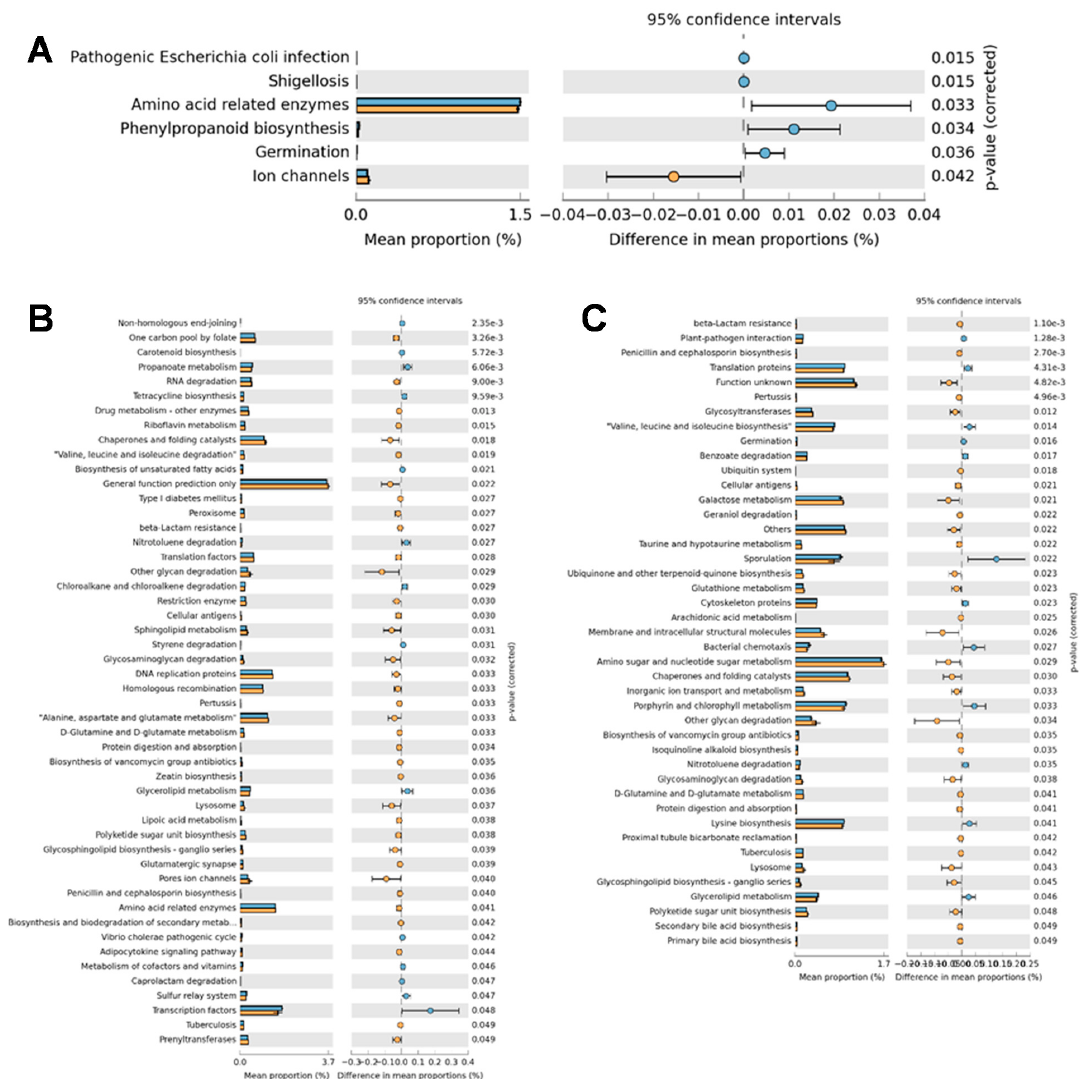
Figure 3. Predicted functions of the ileal digesta ( A ) and cecal content ( B and C ) microbiota of broilers 31325. Blue bar = uninfected group; orange bar = infected group ( A , B ) or infected + probiotic group ( C ).